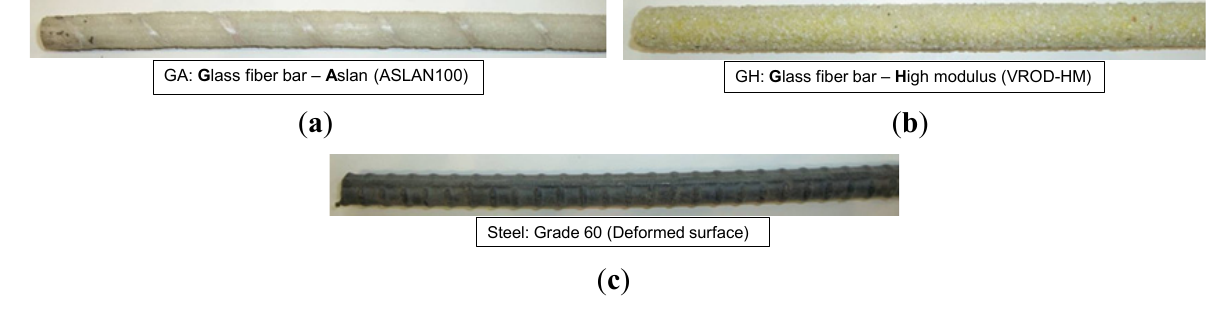
Table 1. Mechanical properties of FRP